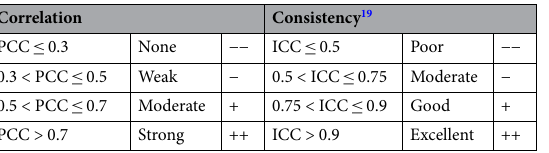
Table 2. Statistical analysis: perfect correspondence values for correlation (by PCC ) and consistency (by ICC )